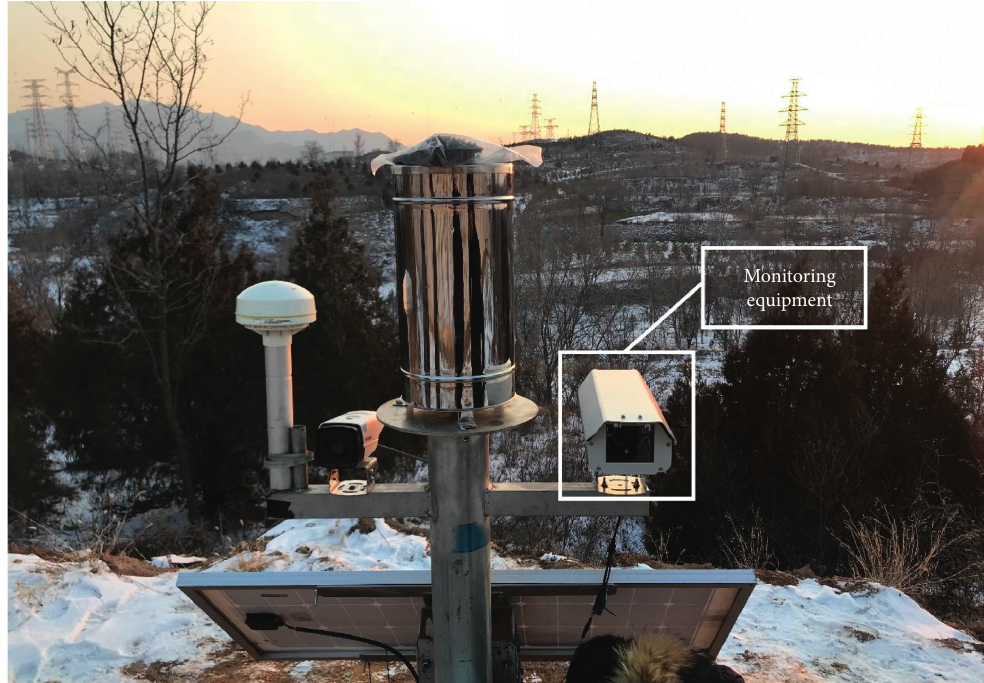
Figure 6: Monitoring